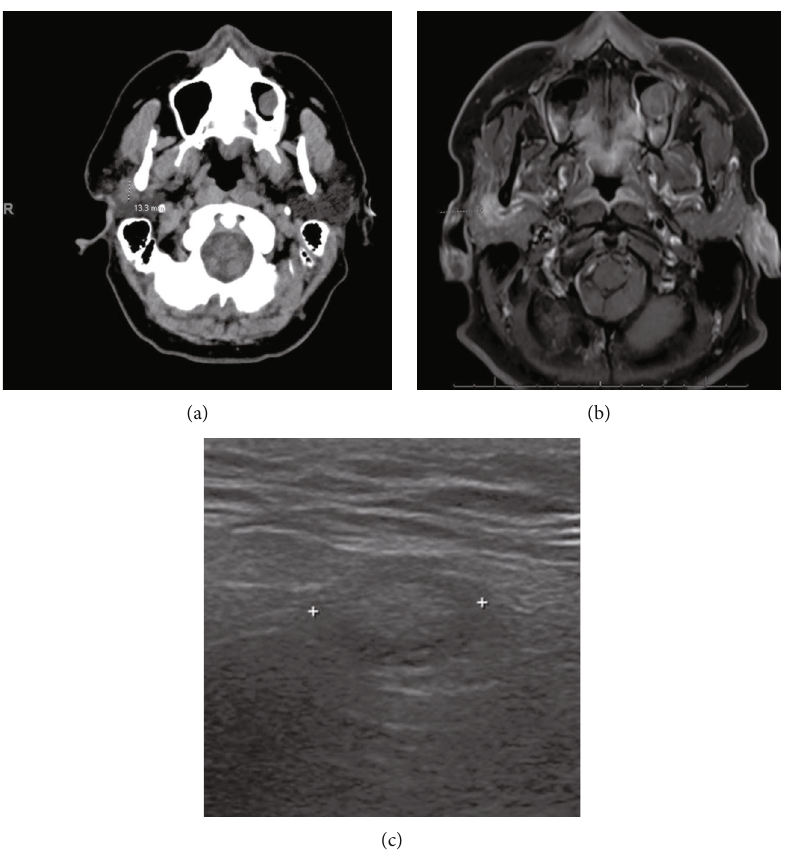
Figure 1: Imaging of the right parotid gland. (a) CT with contrast demonstrating increased soft tissue density. (b) MRI demonstrating mass- like enhancement. (c) Ultrasound demonstrating a poorly de fi ned